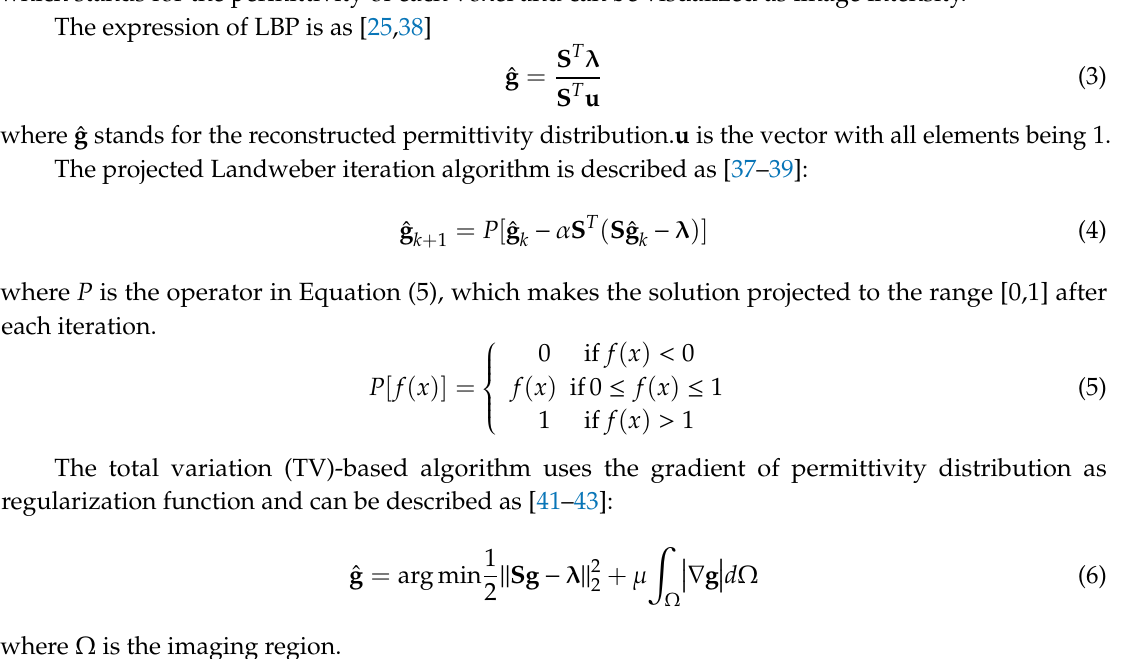
Figure 8. Plexiglass slab and capacitance sensor array used in experiment. ( a ) Top view of plexiglass slab, ( b ) top view of capacitance sensor array, ( c ) plexiglass slab covered with sensor array.